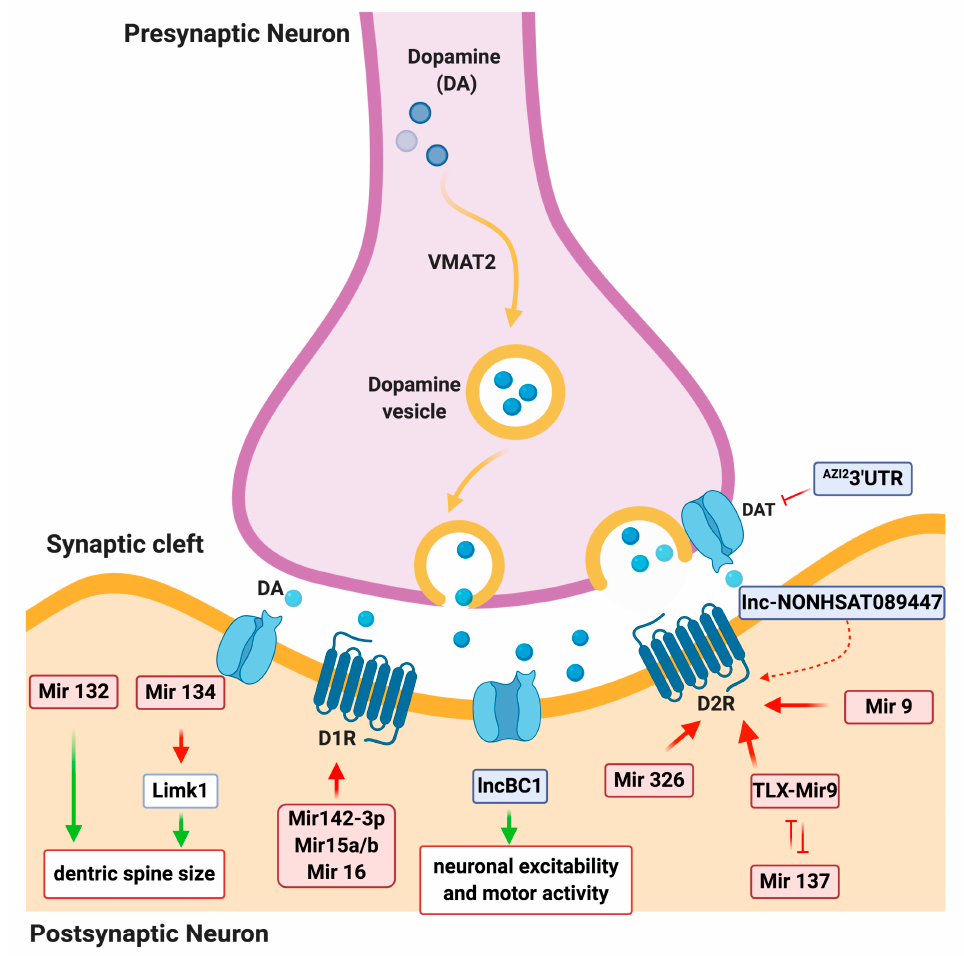
Figure 2. ncRNA network involved in DA neuron signaling. The picture represents the main microRNA and long noncoding RNAs involved in the regulation of dopamine (DA) neuron signaling, VMAT2 (vesicular monoamine transporter 2), and DAT (dopamine transporter). Red arrow-heads or flat-heads indicate positive or negative direct modulation of the indicated genes, respectively. Green arrows indicate overall modulation of a biological process. Dashed lines indicate hypothetical direct or indirect modulation. ncRNAs are highlighted by colored boxes.